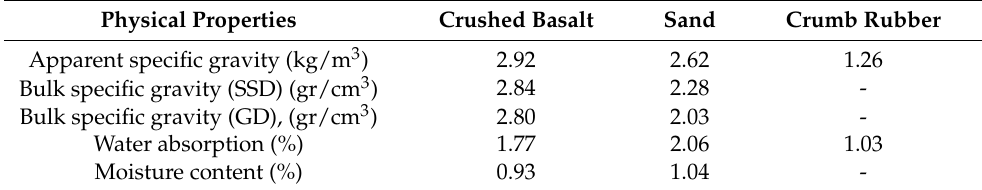
Figure 1. The recycled materials obtained from waste tires. ( a ) Crumb rubber, ( b ) recycled steel bead wires. Table 1. Physical properties of natural and crumb